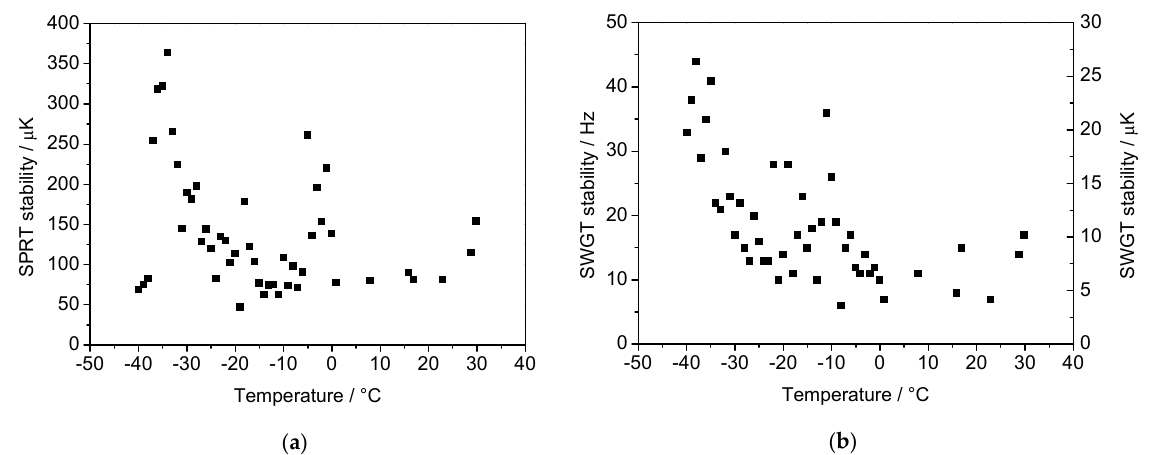
Figure 11. ( a ) Stability of the temperature calibration bath in terms of standard deviation at each temperature set point. ( b ) Stability of the resonant frequency in terms of standard deviation expressed in Hz and converted in temperature unit. The SWGT temperature measurement is more stable compared to the bath temperature because of the large copper cavity thermal mass, which was able to filter out the bath temperature fluctuations.